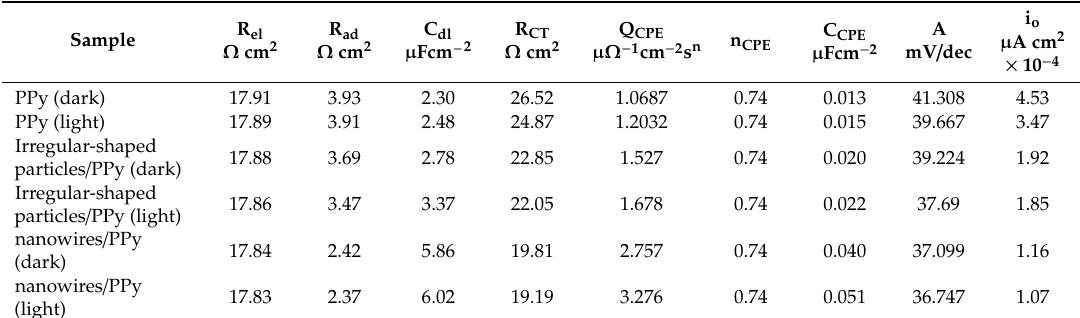
Table 2. Data from electrochemical impedance spectroscopy (ohmic resistance (R el )),